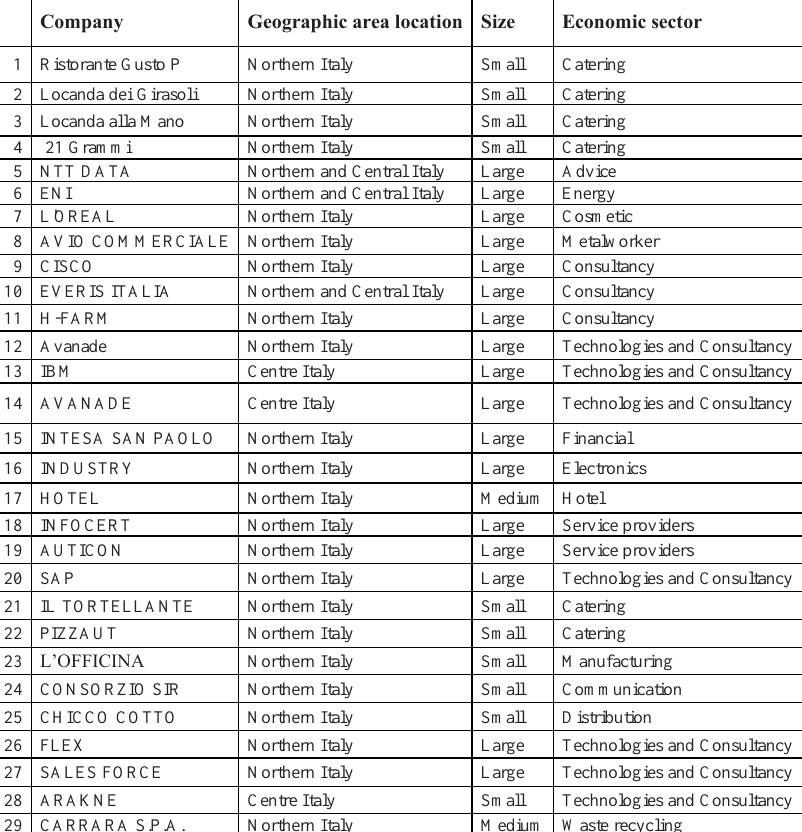
Table 1: Overview of the Italian firms